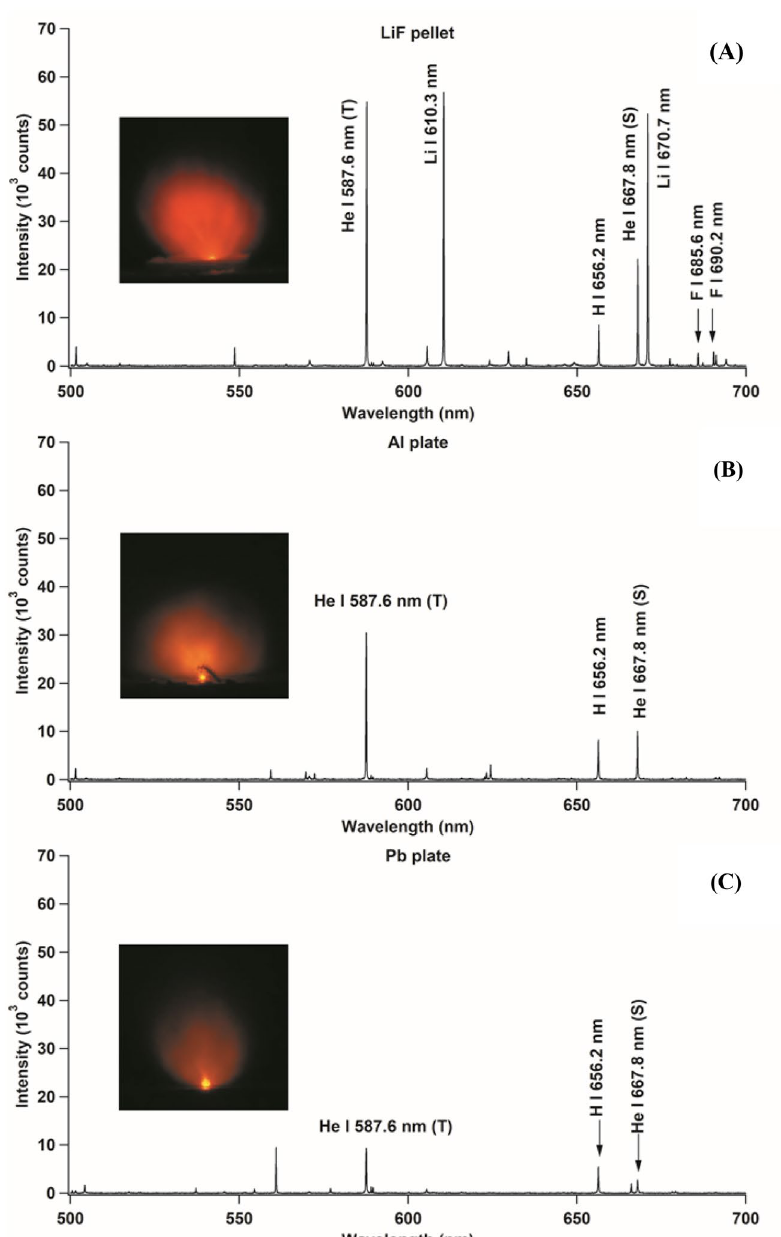
Figure 2. Emission spectra of the He gas plasma when only the first laser with an energy of 82 mJ is focused onto different sub-targets; ( A ) LiF, ( B ) Al, and ( C ) Pb in the surrounding He gas at 3 kPa. Inset shows a photograph of the produced plasma. The gate delay and gate width of the detection system were set as 200 ns and 50 μs, respectively, after the initiation of the first laser ( T triplet, S